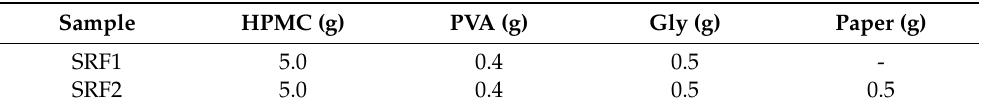
Table 4. Composition of the